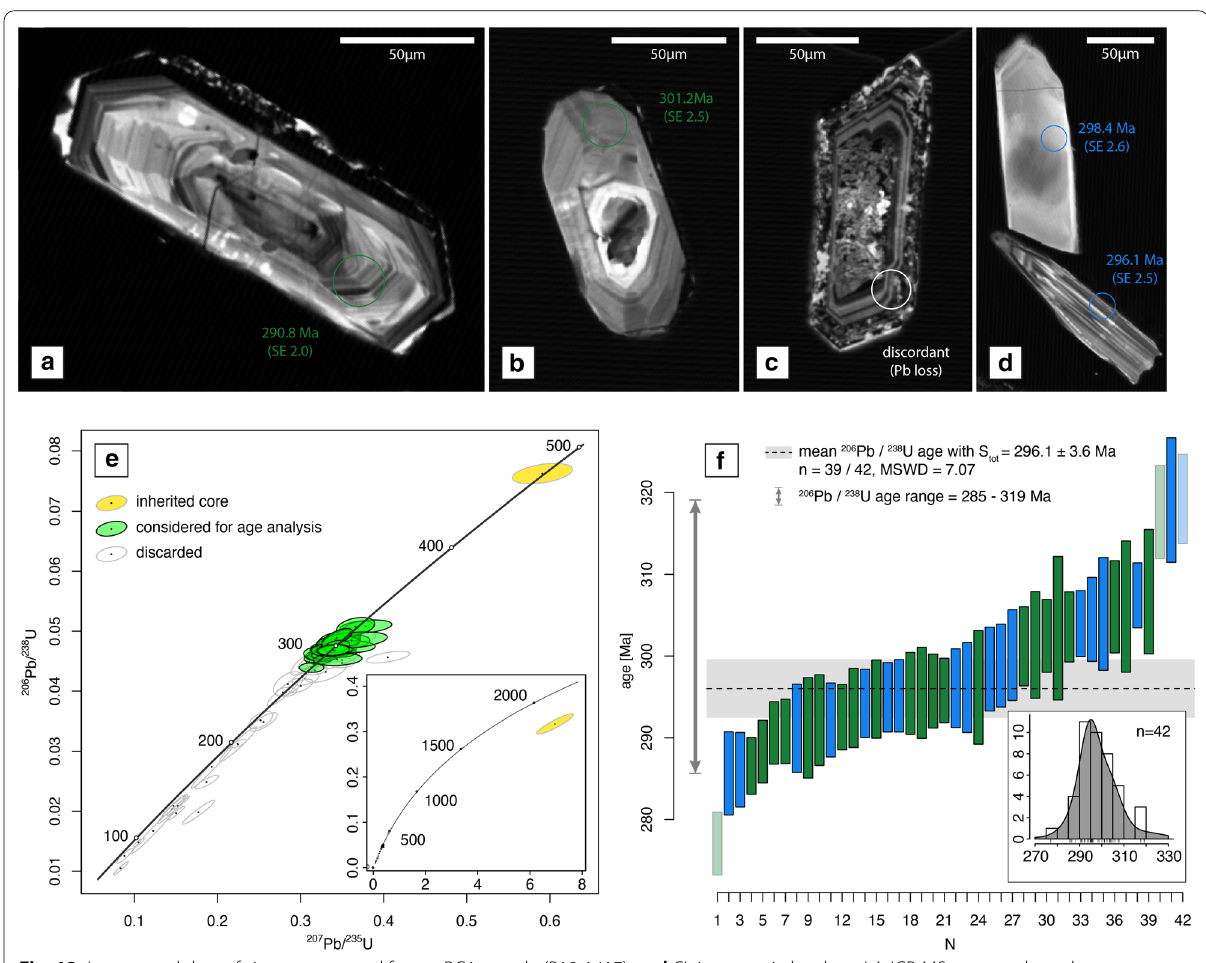
Fig. 12 Images and data of zircons separated from a RG1 sample (B19-1417). a – d CL-images, circles show LA-ICP-MS spots and numbers next to it show the corresponding 206 Pb / 238 U -age with one standard error (in brackets). Green spots indicate LA-ICP-MS measurements of domains with oscillatory zoning ( a and b ), white spots of domains with ‘spongy texture’ ( c ), and blue spots of domains with blurred zoning or homogeneous texture ( d ). e Concordia diagram of all LA-ICP-MS measurements (inner figure) and a close-up view up to 500 Ma (main figure). Data highlighted in green correspond to data shown in subfigure ( f ) and are potentially respected for the age determination. Data points with indications of inherited cores are marked in yellow. Basis for discarding additional data (non-filled error ellipses) is indicated in Additional file 4. Error ellipses correspond to two standard errors. f 206 Pb / 238 U -ages of the potentially respected data for the age determination. Length of the bars correspond to two standard errors. For the determination of the mean age and the age range, the brightened age data were discarded based on a modified version of Chauvenet’s criterion (Vermeesch, 2018). Colors indicate different textures, which correspond to colors in CL-images. Inner figure shows a